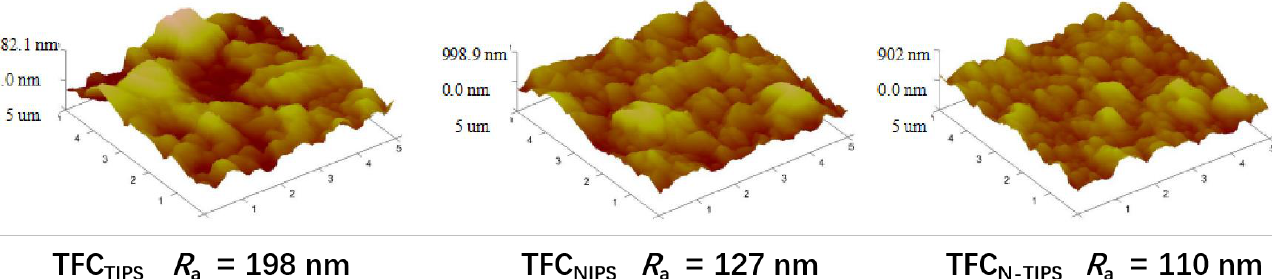
Figure 7. AFM images of TFC-FO membranes with different CTA porous substrates.